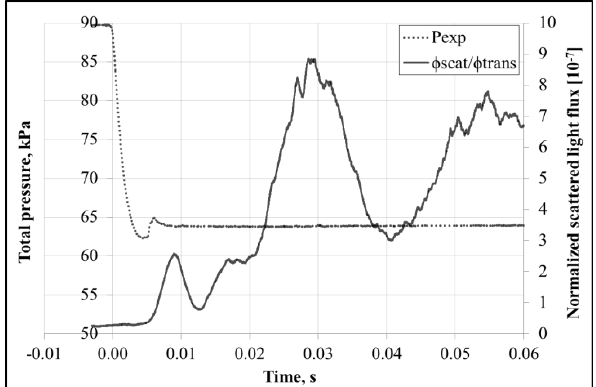
Fig. 3 . Result of a typical single homogeneous nucleation experiment showing the total pressure and the light flux scattered at an angle of θ = 15˚ normalized with respect to the transmitted light flux as functions of time